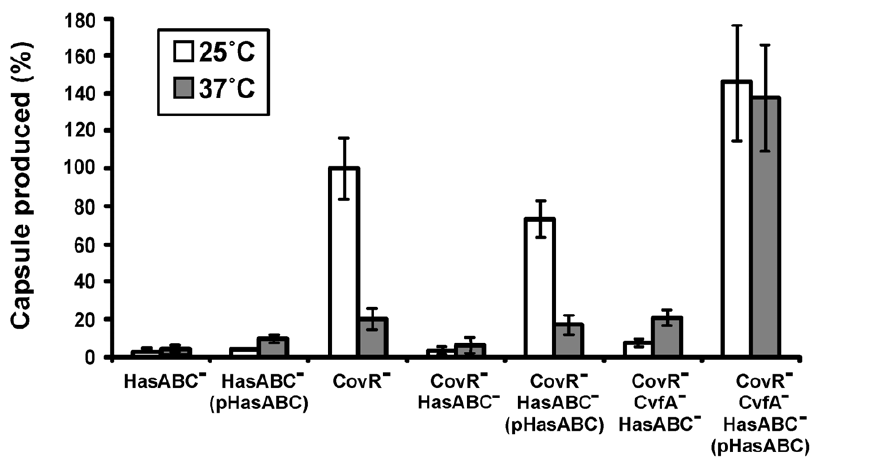
Figure 4. Expression of the capsule genes intrans under a heterologous promoter also exhibits capsule thermoregulation. The hasABC genes were expressed in trans under the rofA promoter on pHasABC and transferred to S. pyogenes HSC5 strains whose expression of chromosomal capsule genes was blocked by disrupting the first transcribed capsule gene, hasA . Those complemented strains with pHasABC exhibited the same phenotype of capsule thermoregulation as the strains whose capsule genes were expressed under the native promoter on the chromosome. The following strains were used: CovR 2 strain (CovR 2 ), CovRIFD; chromosomal capsule gene knock-out strain (HasABC 2 ), V HasA; in trans capsule gene complemented strain (HasABC 2 (pHasABC)), V HasA(pHasABC); CovR 2 HasABC 2 strain (CovR 2 HasABC 2 ); CovRIFD: V HasA; CovR 2 HasABC 2 strain complemented with pHasABC (CovR 2 HasABC 2 (pHasABC)), CovRIFD: V HasA(pHasABC); CovR 2 CvfA 2 HasABC 2 strain (CvfA 2 CovR 2 HasABC 2 ), CovRIFD:TnCvfA1: V HasA; CovR 2 CvfA 2 HasABC 2 strain complemented with pHasABC (CvfA 2 CovR 2 HasABC 2 (pHasABC)),